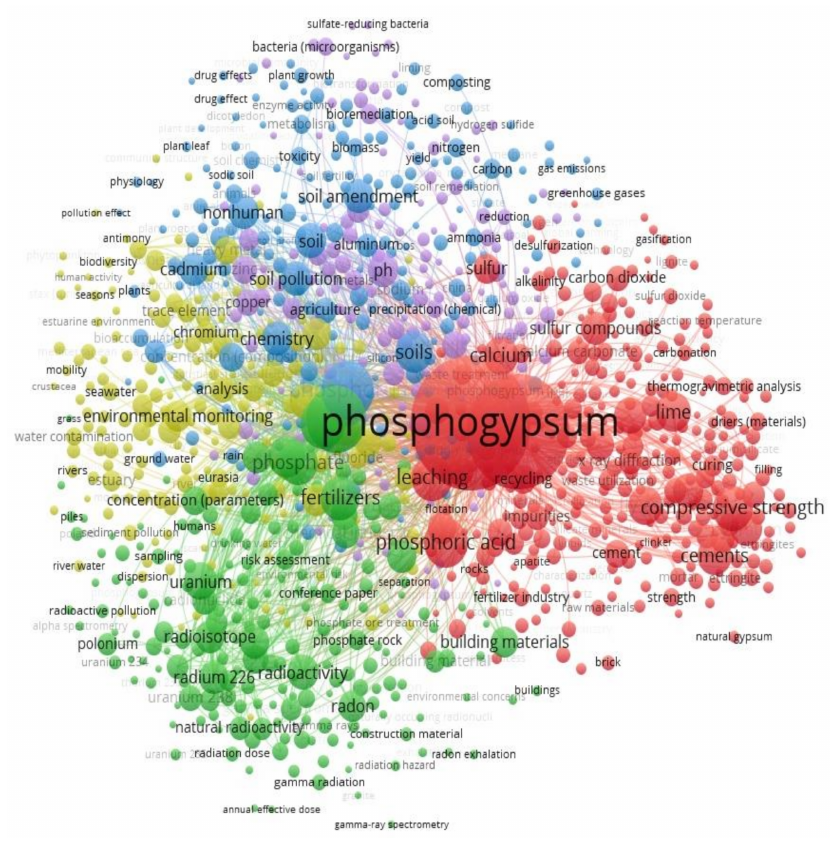
Figure 5. General network visualization ( с onstructed via VOSViewer v.1.6.15): 5 clusters, 94,846 links, 209,564 total link